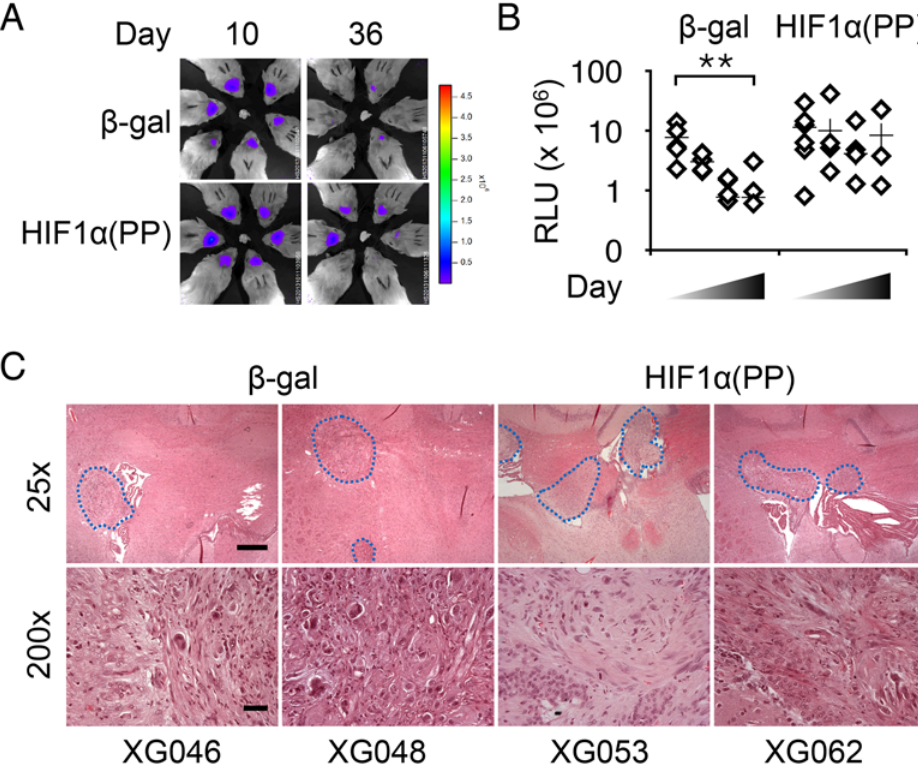
Fig 5. Intermittent induction of HIF1 α (PP) facilitated intracranial tumor growth of U-118 MG cells. (A) Bioluminescent imaging analysis of intracranial tumors derived from 8-week treated cells as indicated. (B) Tumor volumes, plotted in a log scale, from β -gal cells decreased significantly during the course of 49 days, but those from HIF1 α (PP) did not. ** , p -value < 0.01. (C) Representative tumor lesions are shown in hematoxylin and eosin staining from 2 individual mice of each group at 25× and 200× magnifications, with scale bars of 1 mm and 100 μ m,